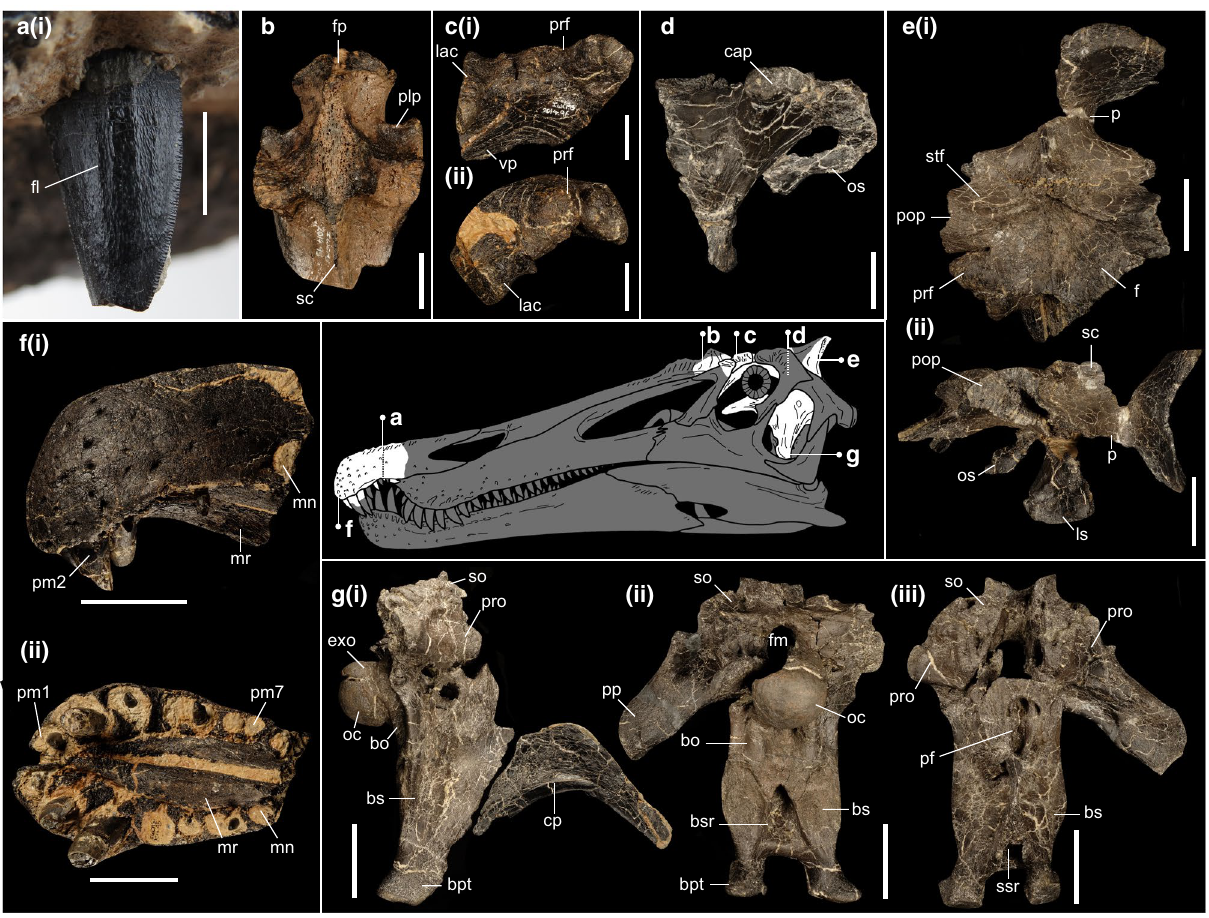
Figure 4. Cranial material of Riparovenator milnerae . ( a ) Close up of holotype in situ RpmVII (IWCMS 2014.95.6), in labial view; ( b ) referred posterior nasal fragment (IWCMS 2014.95.7) in dorsal view; ( c ) holotype left preorbital fragment (IWCMS 2014.96.3) in (i) lateral and (ii) anterodorsal view; ( d ) holotype right laterosphenoid (IWCMS 2014.96.2) in lateral view; ( e ) holotype skull roof and associated left laterosphenoid (IWCMS 2014.96.1) in (i) dorsal and (ii) left lateral views; ( f ) holotype premaxillary bodies (IWCMS 2014.95.6) in (i) left lateral and (ii) ventral views; ( g ) holotype basicranium (IWCMS 2020.448.1) in (i) right lateral (with fractured cultriform process IWCMS 2020.448.2), (ii) posterior and (ii) anterior views. bo basioccipital, bs basisphenoid, bpt basipterygoid process, bsr basisphenoid recess, cap capitate process of the laterosphenoid, cp cultriform process, exo exoccipital, f frontal, fl fluting, fm foramen magnum, fp frontal process, lac lacrimal, ls laterosphenoid, mn maxillary notch, mr median ridge, oc occipital condyle, os orbitosphenoid, p parietal, plp posterolateral process, pop postorbital process, pm(n) premaxillary tooth/alveolus (tooth position), prf prefrontal, pro prootic, sc sagittal crest, scr subcondylar recess, so supraoccipital, ssr subsellar recess, stf supratemporal fossa, vp ventral process of the prefrontal. Skull reconstruction credit: Dan Folkes (CC-BY 4.0). Scale bars ( a ): 5 mm; ( b – d ): 20 mm; ( e – g ): 50